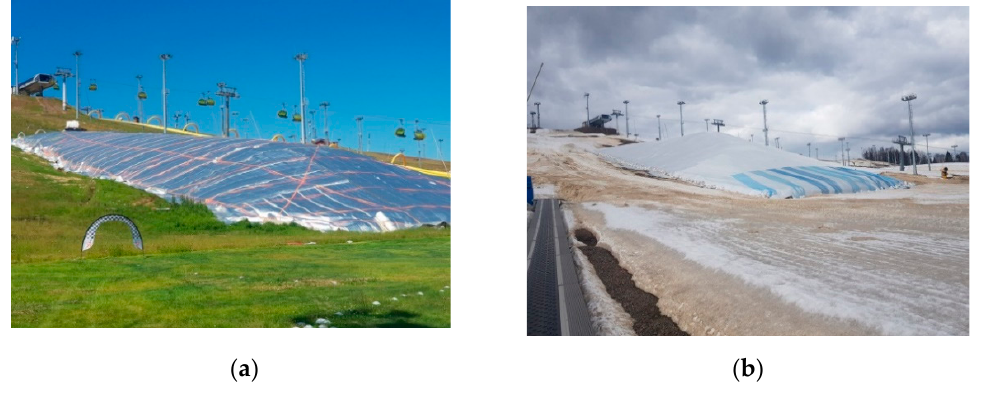
Figure 2. Stored snow reserves under ( a,b ) the “thermal blanket”. The metallised surface of the rolled polyethylene foam and the light-coloured awning ceiling reflect the sun’s rays. The low thermal conductivity of the insulation shell, the sta- bility of its properties and the minimal heat loss at the joints make it possible to achieve a thermal resistance of the insulation shell (“thermal blanket”) in the order of 1.3–1.6 m 2 °C/W. The technology for the protection and preservation (conservation) of snow cover was first implemented in 2013–2014 on the mountain slopes of the Rosa Khutor Olympic area in Sochi. By the start of the 2014 Winter Olympics, about half a billion cubic metres of snow mass had accumulated here. To date, this technology has been used several times, confirming the feasibility of using polyethylene-foam-based shells under negative and changing temperature conditions. The aim of the research presented in this article was to develop a method for selecting a composition of modified polyethylene foam, to conduct studies to assess the flammabil- ity of the materials obtained, to evaluate the properties of polyethylene foam at low tem- peratures, and to develop insulation systems for building structures for operation in con- ditions typical of the Arctic and Antarctic regions and in the presence of permafrost soils. 2. Materials and Methods Foam polyethylene was traditionally used in structures as a lining or vibration- damping material in rolls or sheets whose thickness did not exceed 5 mm. TEPOFOL tech- nology makes it possible to obtain products with a thickness of 5 to 200 mm, which greatly expands the possibilities of using polyethylene foam. The preparation (processing) of secondary polyethylene includes the following tech- nological steps: collection and storage, grinding and agglomeration, removal of foreign inclusions, introduction of modifiers, including flame retardants, granulation. If waste from own production (offcuts, low-quality products) is used, it is granulated after being processed by pyrolysis and the addition of modifiers and then dosed into the feed hopper of the extruder. In the extruder, the polyethylene granulate is melted and the melted mass is mixed under pressure with the foaming agent isobutane. The continuous mixing gives the polymer mass a homogeneous structure, also at the molecular level. The cell size of polyethylene foam is up to 1.2 mm. In the lamination method, the finished polyethylene foam rolls are coated on one or both sides with a heat-reflecting layer of foil or metallised lavsan. To achieve the desired thickness, the layers of foamed polyethylene are welded together by “heat welding”. Originally, the products were monolithic, with welded layers (each 10 mm thick) with or without a heat-reflective coating (Figure 3a). Since polyethylene foam not only has low thermal conductivity but also low vapour and water permeability, as well as high moisture resistance and operational stability in contact with the ground, it became possi- ble to produce seamless insulation shells for various building structures with high insu- lating capacity.